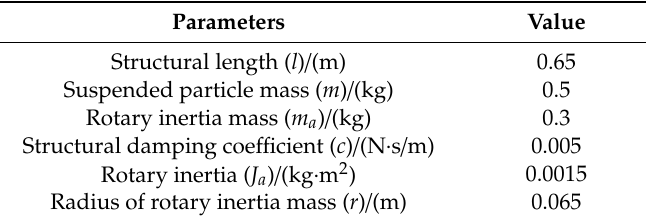
Table 1. Parameter configuration for the numerical